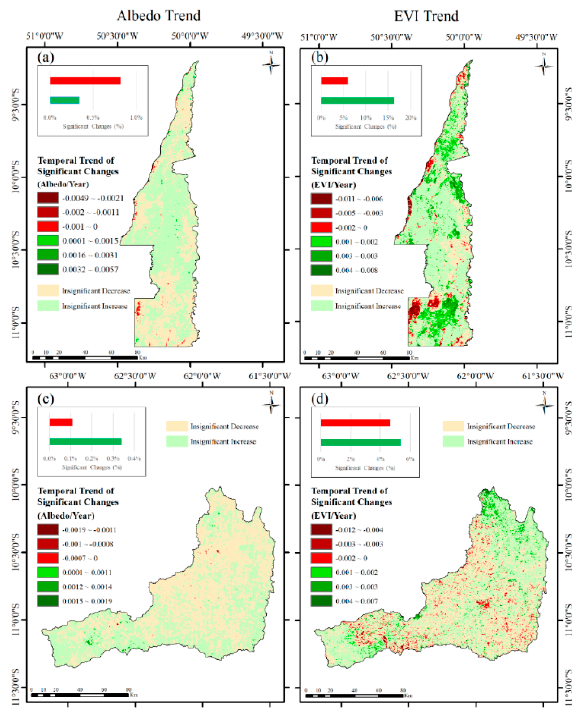
Figure 7. Spatial distribution of the trend per pixel in the period 2001–2016 for: ( a ) albedo in the Ji-Paraná River Basin (JPRB), ( b ) Enhanced Vegetation Index (EVI) in the JPRB, ( c ) albedo in the Araguaia National Park and Cantão State Park (ANP-CSP), and ( d ) EVI in the ANP-CSV.